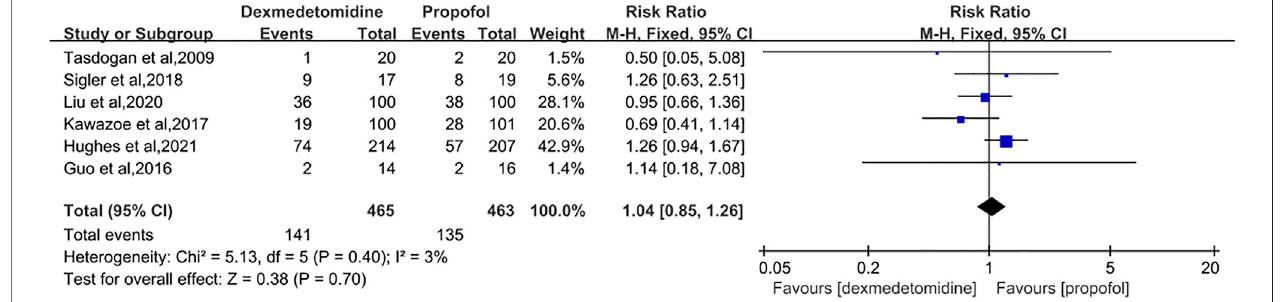
FIGURE 4 | Forest plot comparing the 28/30-day mortality between two groups.